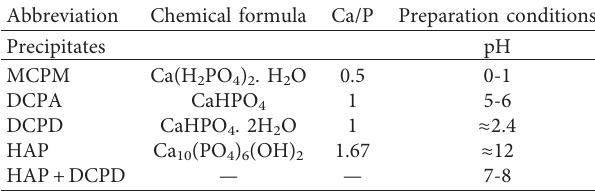
Figure 11: X-ray diffraction diagram of the solid phase formed during the precipitation of MCPM ( M 5). Table 3: pH ranges of precipitated calcium